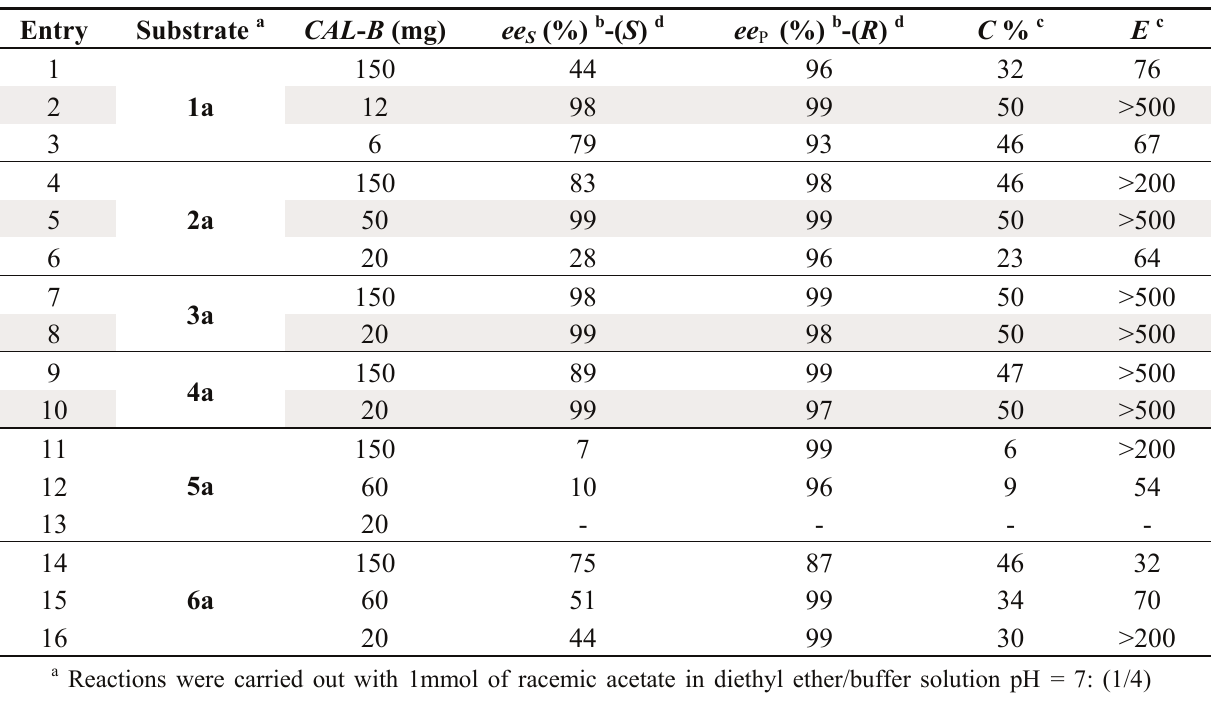
Table 1. Enzymatic hydrolysis of acetates 1a – 6a . The shadowed lines emphasize the best results with high reactivities and selectivities ( C and E